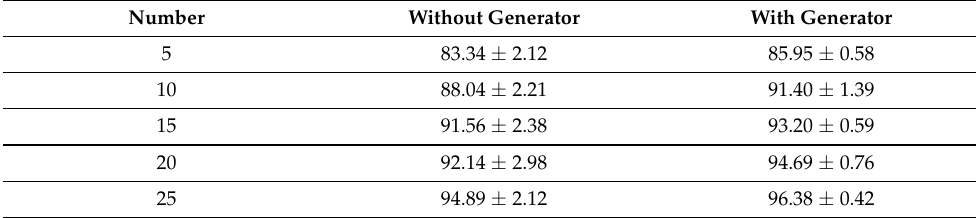
Table 15. The ablation experiments on the Pavia University dataset (OA) (%).